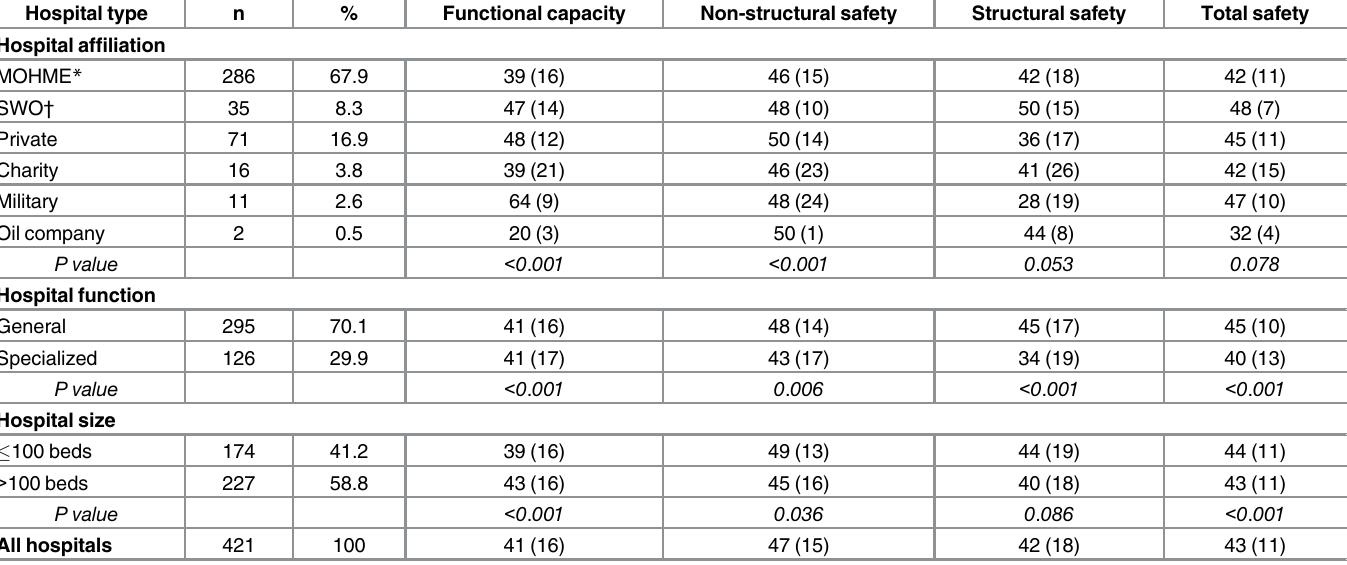
Table 2. Average safety score of functional capacity for disasters in 421 of Iran ’ s hospitals,